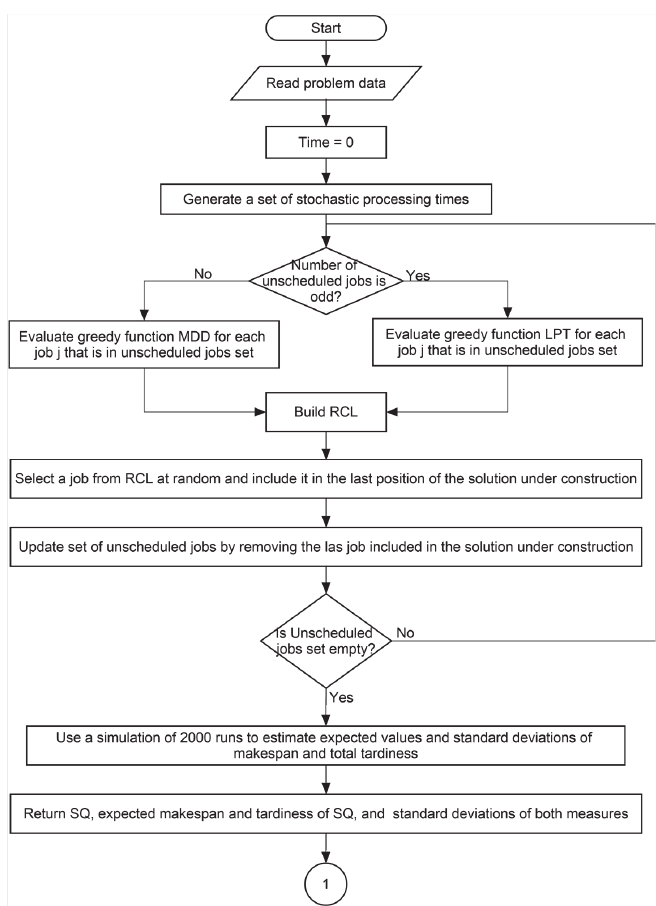
Fig. 2. Flow diagram of Construction phase of